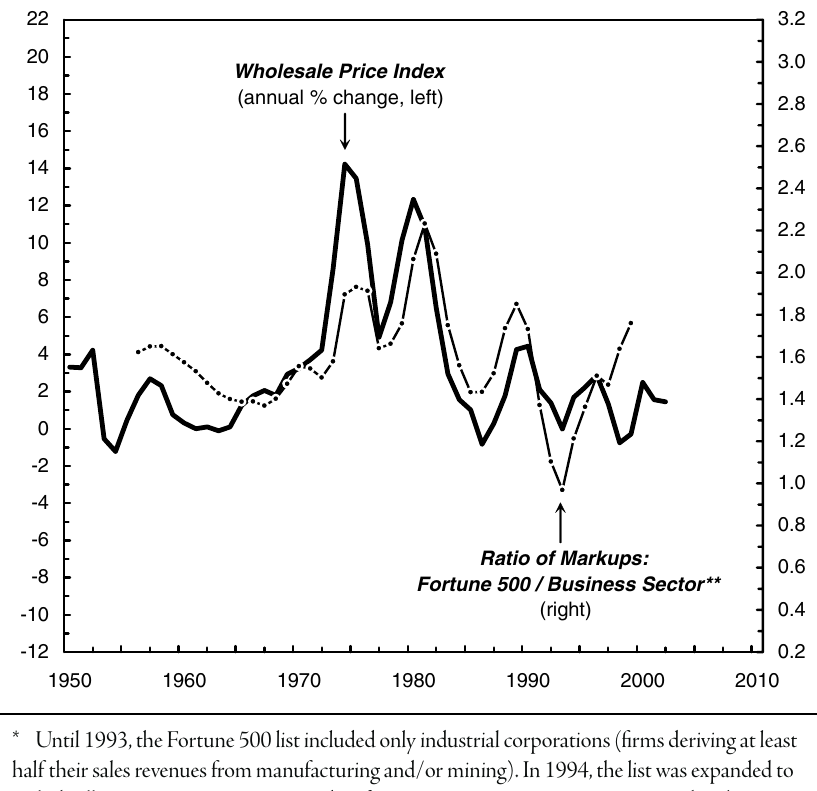
Figure 4 – U.S. Inflation and Capital-Labor Redistribution* Figure 5 – U.S. Inflation and Differential